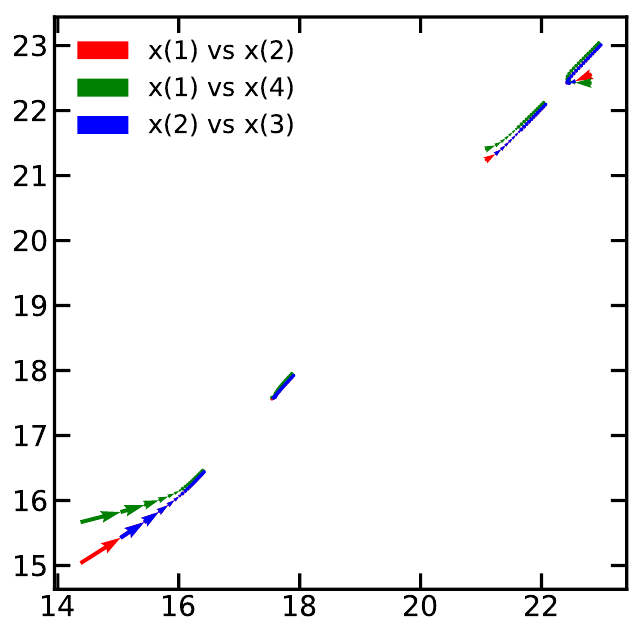
Figure 14. Phase diagram during a fault in